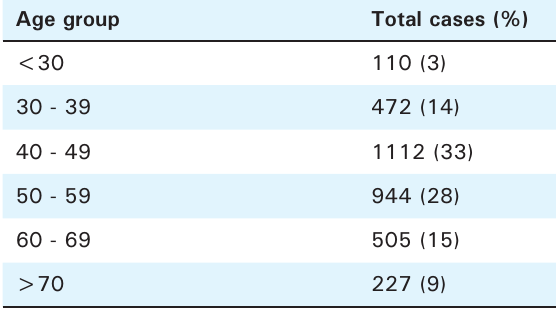
Table 2. Age-wise Distribution of cases